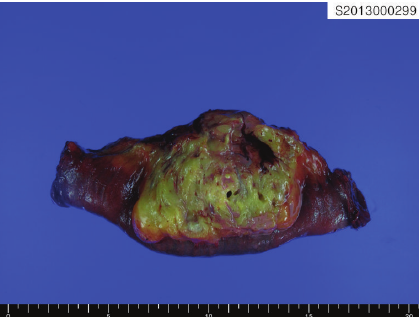
Figure 2: Gross appearance of the tumor. The cut surface of the tumor is yellowish, well demarcated, and partially encapsulated and shows small nodules of firm white tissue, corresponding to smooth muscle. The tumor does not invade the jejunal